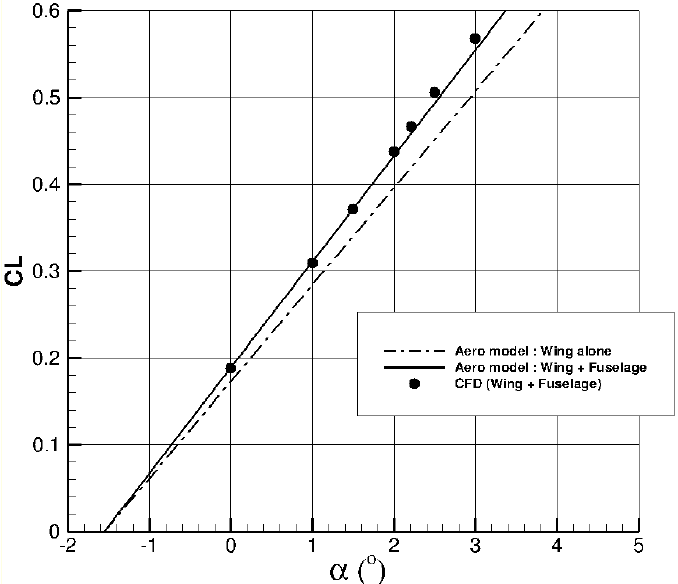
Figure 19. CRM configuration—fuselage effect on the C L ( α ) curve. Lines—aerodynamic module; symbols—CFD.